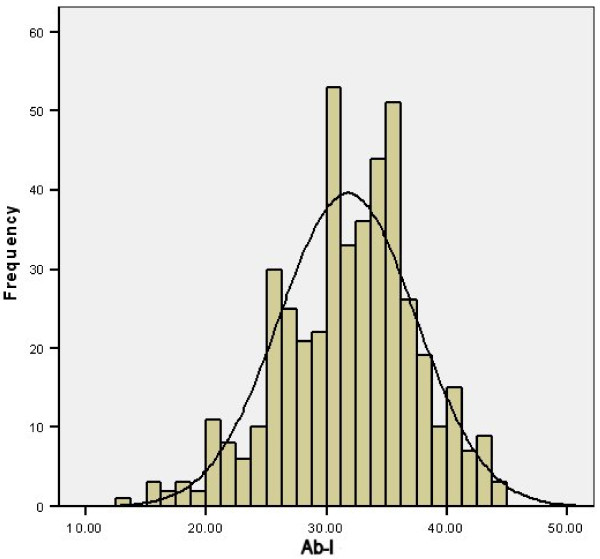
Histogram of Ab-I.